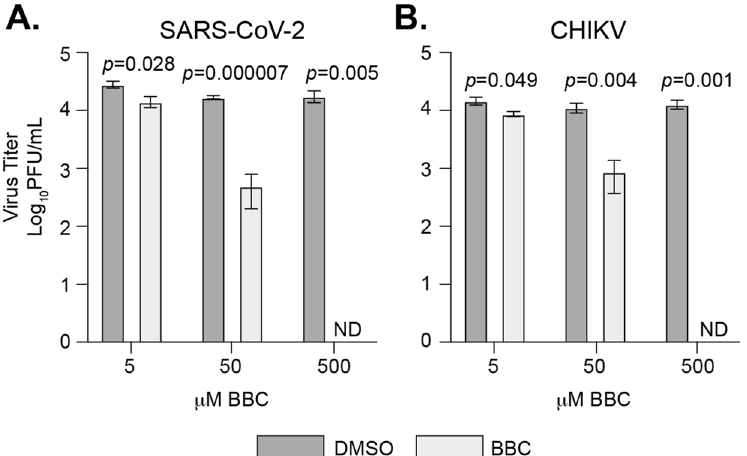
Figure 6. Berberine chloride inhibits SARS-CoV-2 infection. ( A ) SARS-CoV-2 (MOI = 0.1) or ( B ) CHIKV (MOI = 1) were incubated with BBC or DMSO for 1 h at 37 °C. Infectious particles were quantified by plaque assay on Vero E6 cells. Data represent the mean and range of two independent experiments with internal duplicates. Students t -test. ND = not detected (below limit of detection).